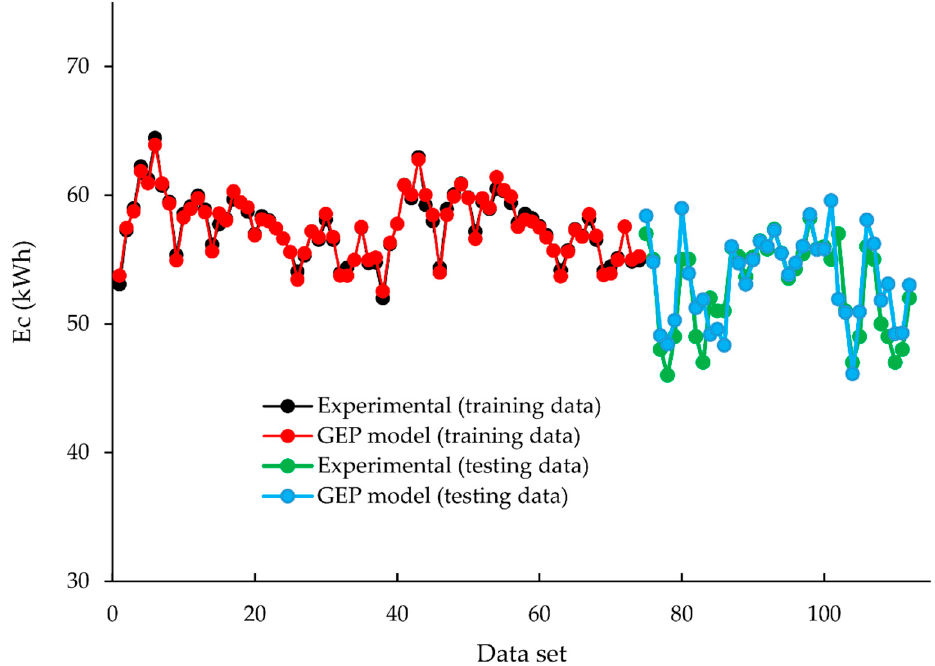
Figure 8. Comparison of the experimental and predictive dataset for training and testing phase based on GEP model.